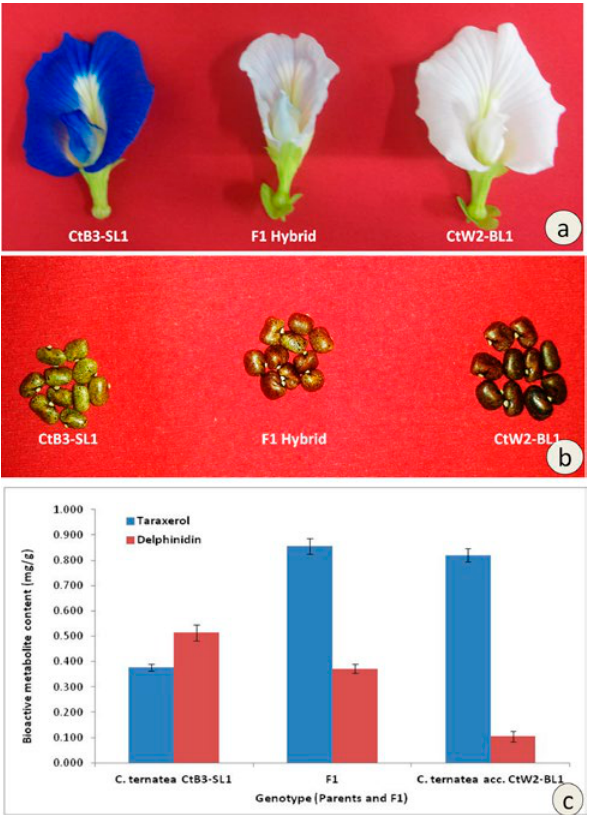
Fig. 1. Characterization of intra-specific F 1 hybrid along with its parents ( C. ternatea acc. CtB3-SL1 and C. ternatea acc. CtW2-BL1 ). Floral attributes including petal colour (a), Mature seeds showing colour of the seed coat and aril (b); Graphical representation of bio- active metabolites (taraxerol and delphinidin)